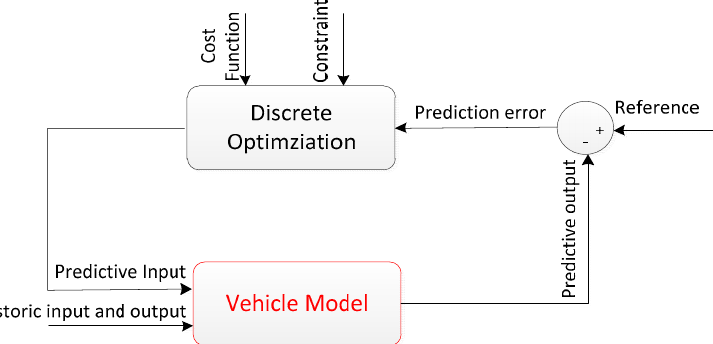
Figure 9. The principle of the model predictive control.